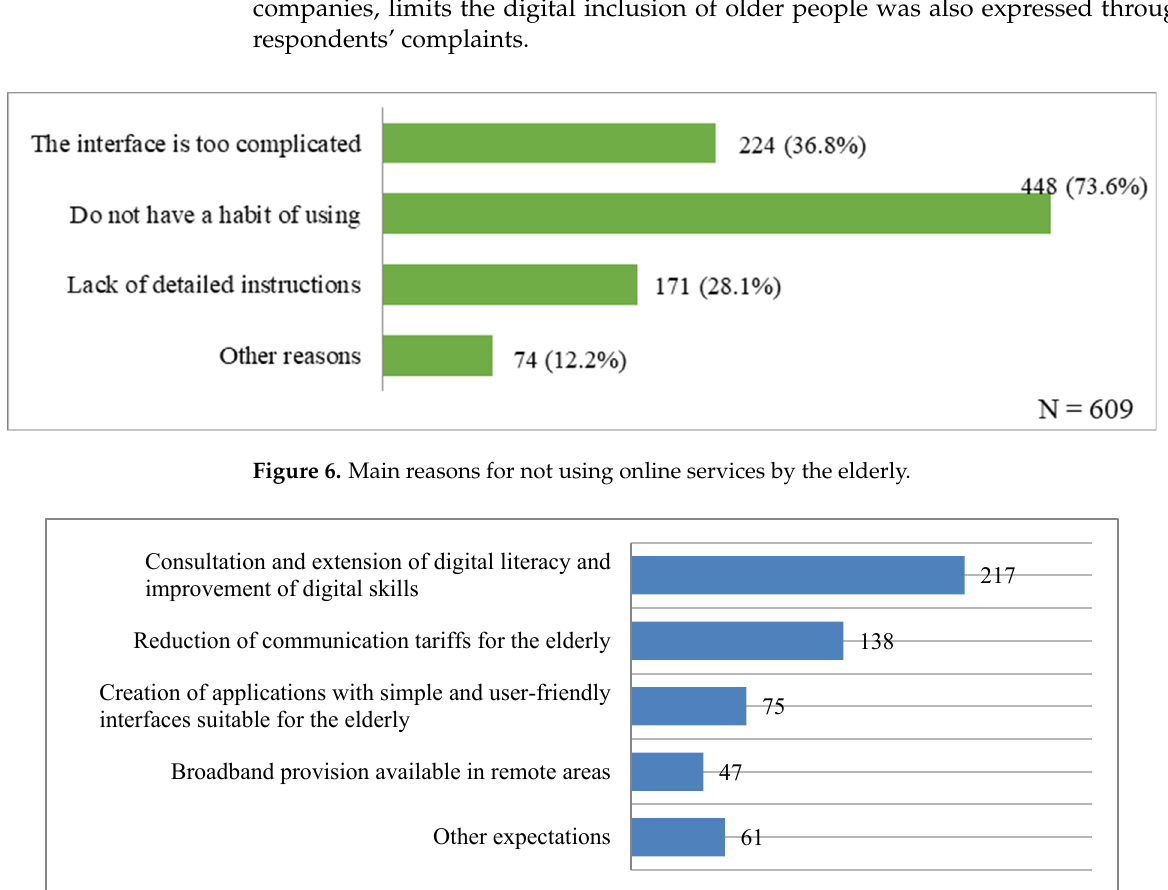
Figure 7. The expectations of older people to adapt to the digital society.